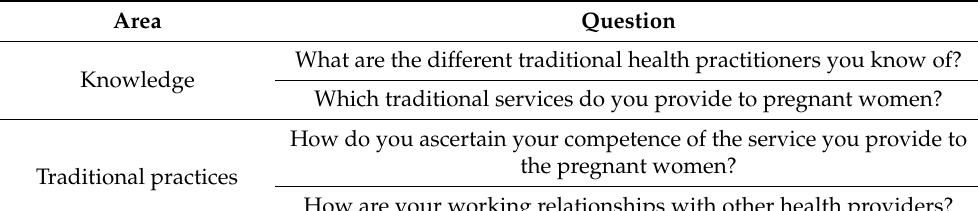
Table 1. Discussion guide. Area Question